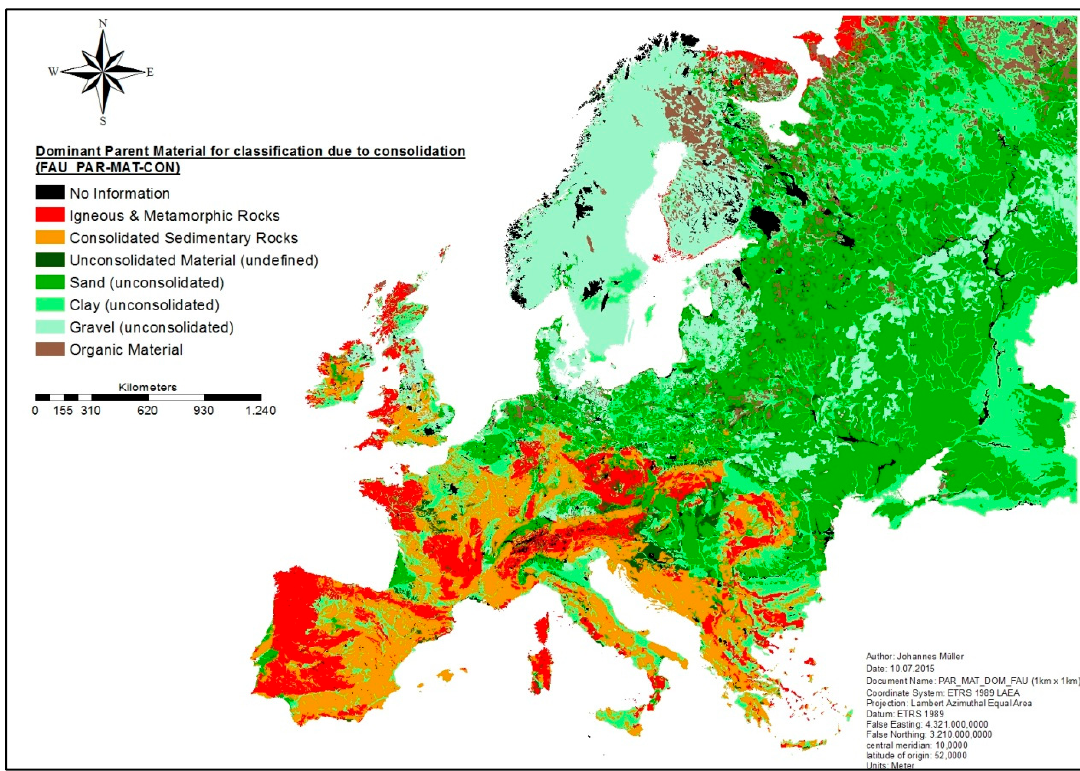
Figure 5. Map for the dominant parent material for a classification due to hardness. The map allows assertions about the level of hardness and drillability.